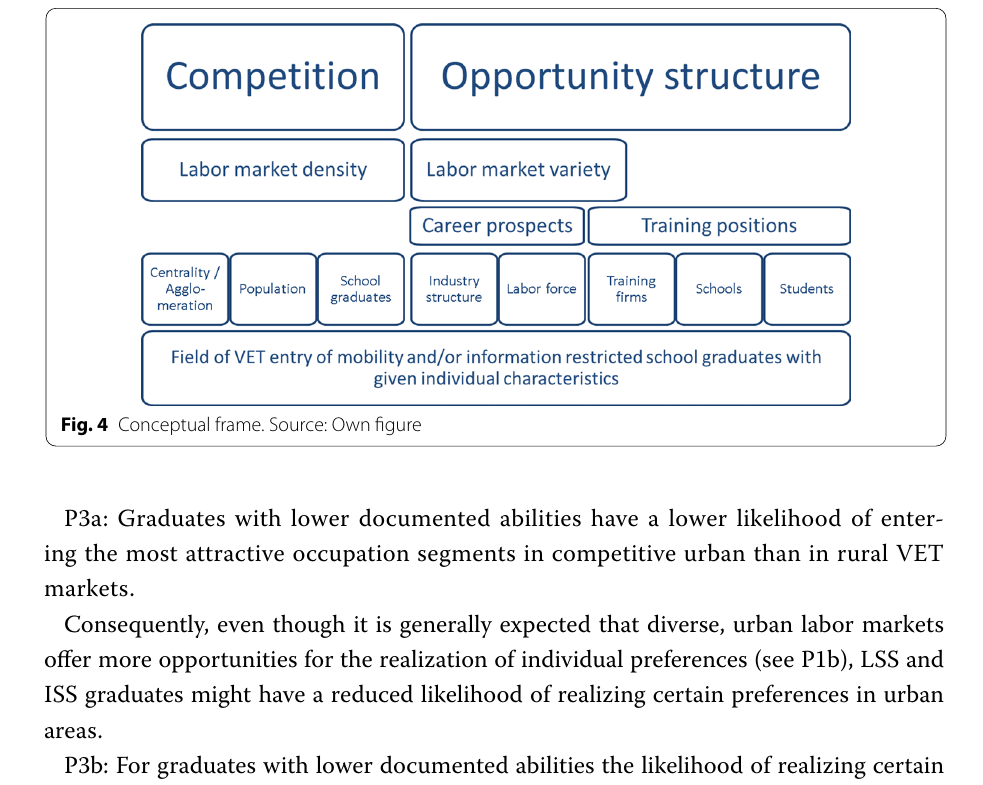
P3a: Graduates with lower documented abilities have a lower likelihood of enter- ing the most attractive occupation segments in competitive urban than in rural VET markets.